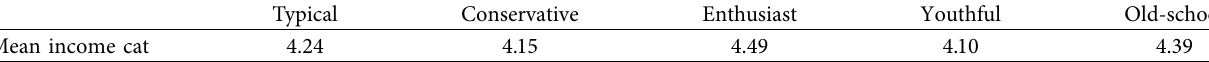
Table 5: Classes of consumers and income categories.